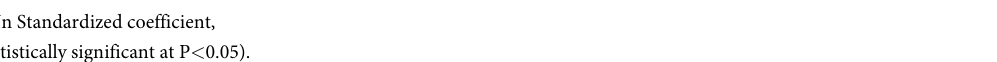
Table 12. Multiple linear regression analysis of factors associated with ALT, AST, serum total bilirubin and serum total protein. AST ALT Total bilirubin Total protein Variable β (95% CI) P-value β (95% CI) P-value β (95% CI) P-value β (95% CI) P-value Status (44) 37.5 0.00 �